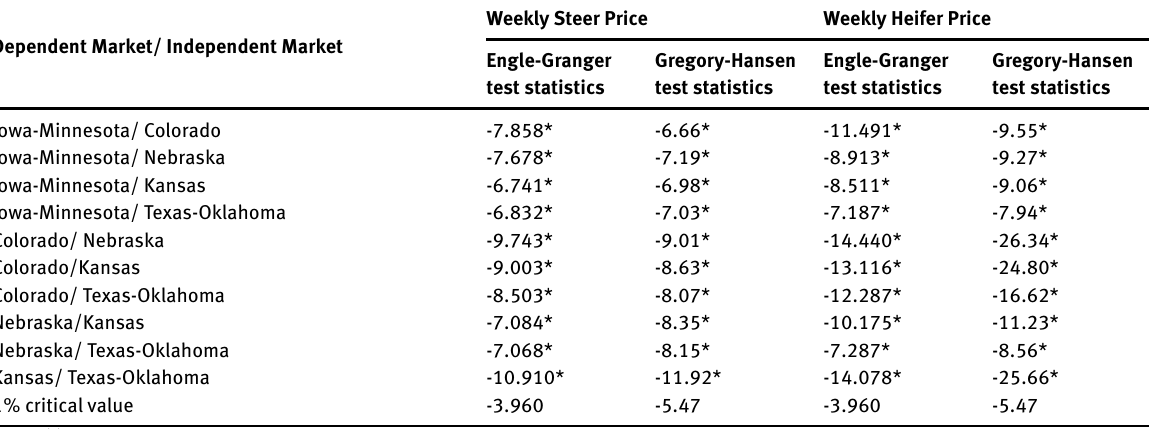
Table 3: Univariate Cointegration Test Results for Live Steer and Heifer Prices